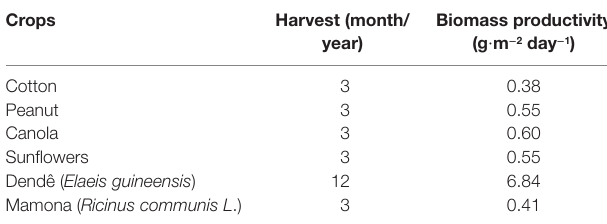
TaBle 4 | crops productivity [adapted from Trzeciak et al. (2008)].